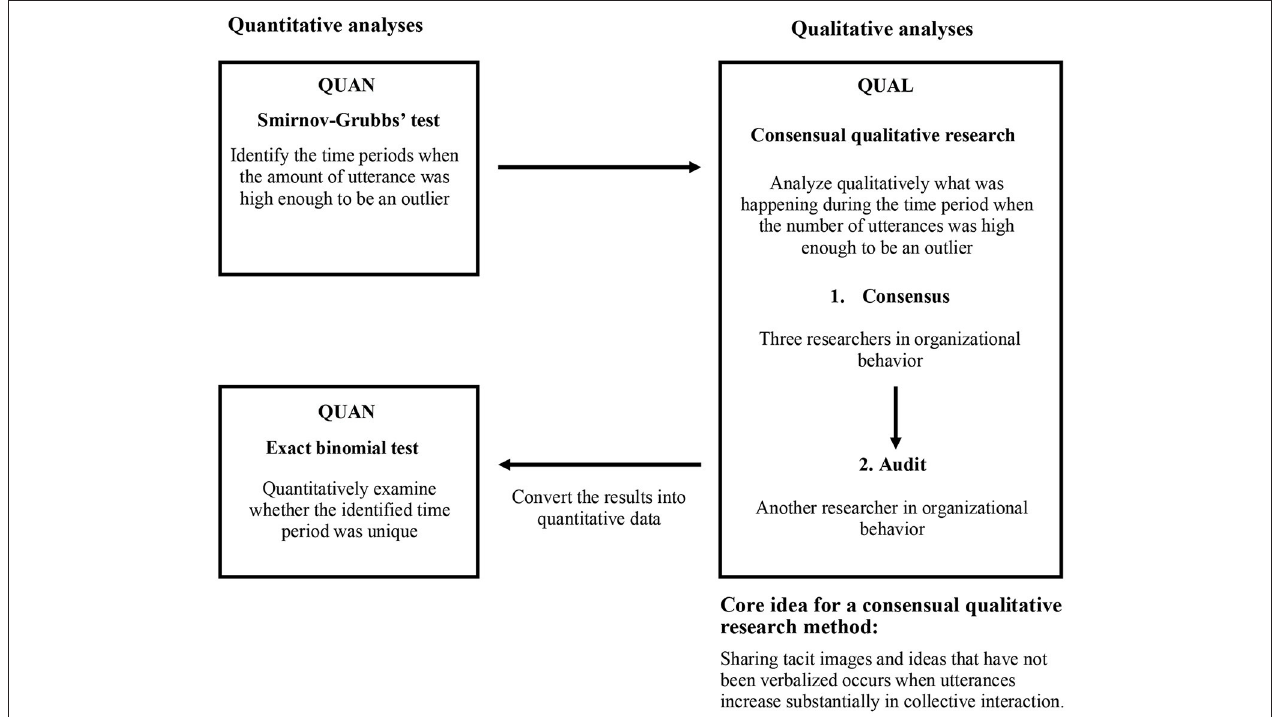
FIGURE 1 | Flow of the mixed methods research, QUAN + QUAL + QUAN design in the Convergent